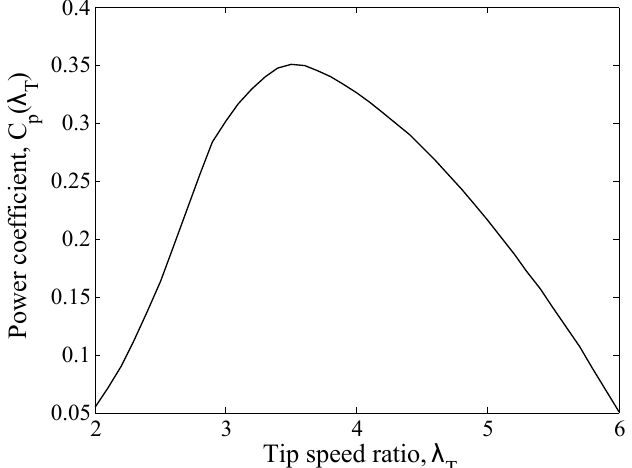
Figure 2. Turbine power coefficient as a function of the tip speed ratio with a max C 0.35 at a tip speed ratio (TSR) of 3.5.